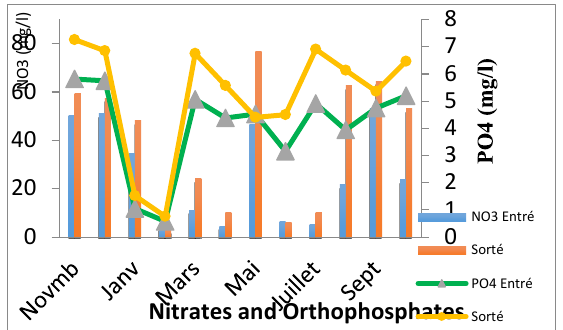
Figure 9. Variation of the values of Nitrates and